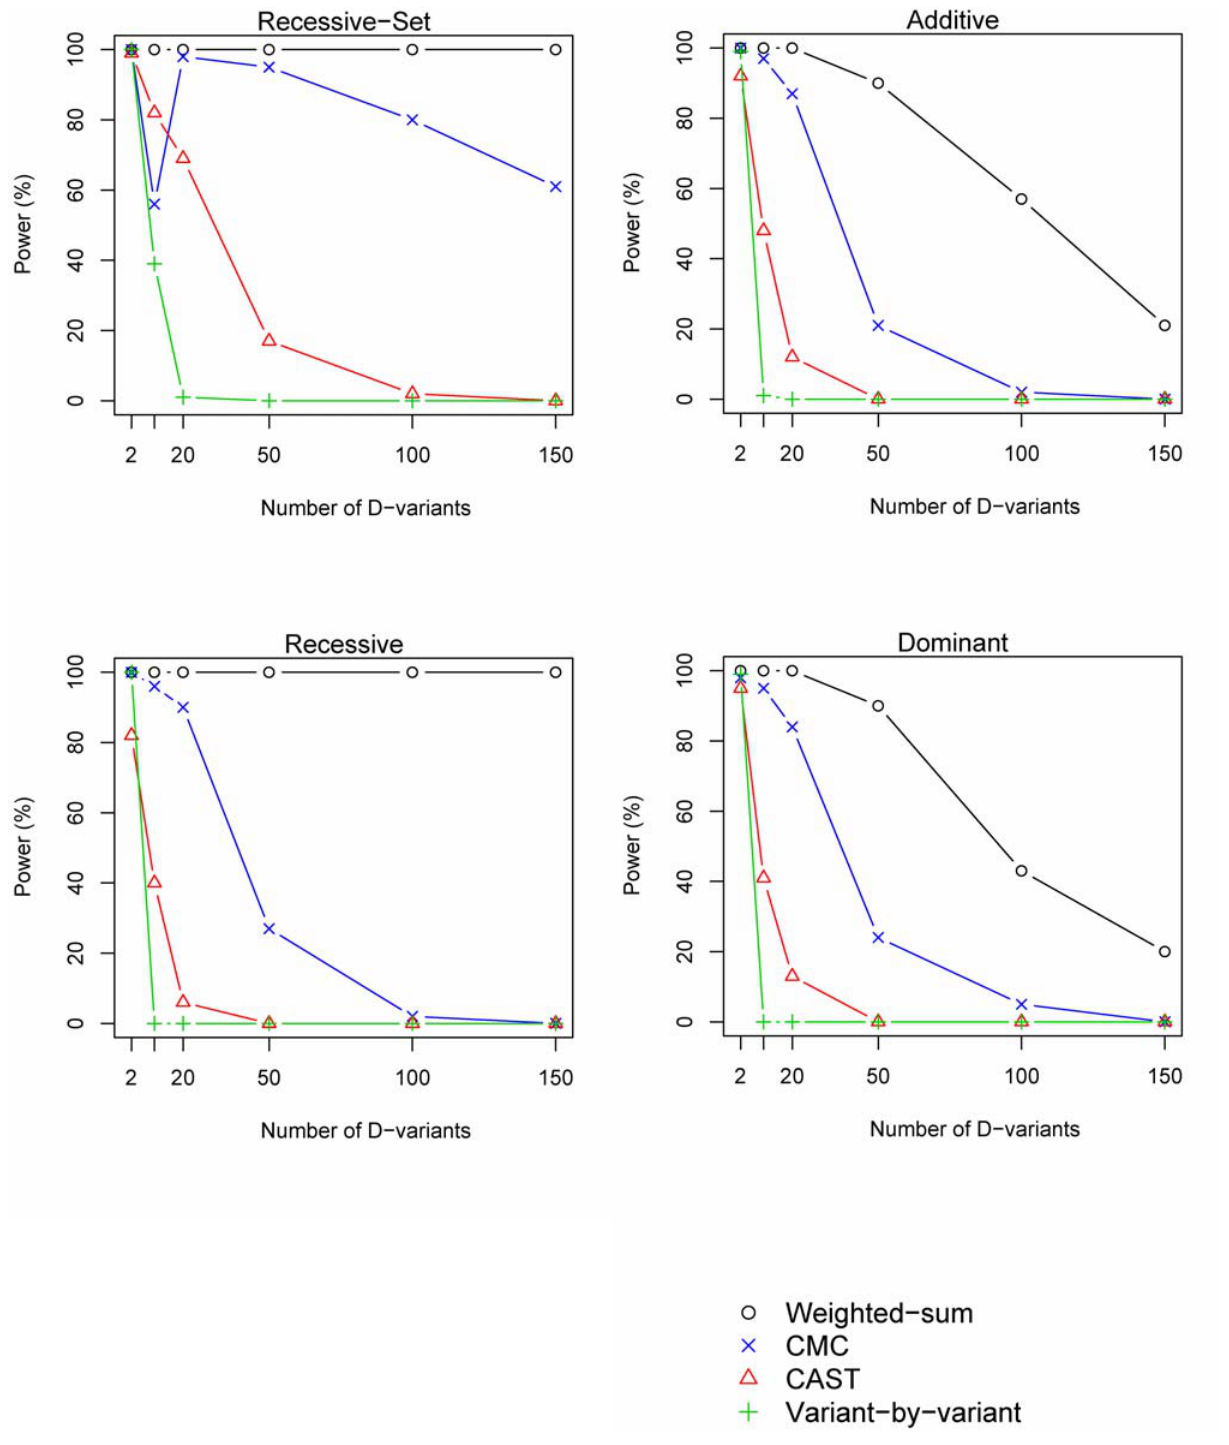
Figure 3. Power versus number of D-variants. The power of the investigated methods is shown for different number of D-variants (disease-risk contributing variants). The power simulations were performed using n A = n U =1000 individuals, 50% D-variants, group PAR of 10% and p M =10%. Note that the jump in the power for the CMC method under the Recessive-set model occurs because a low number of variants yields a high allele- frequency of each variant, and the variants are hence not grouped by the CMC